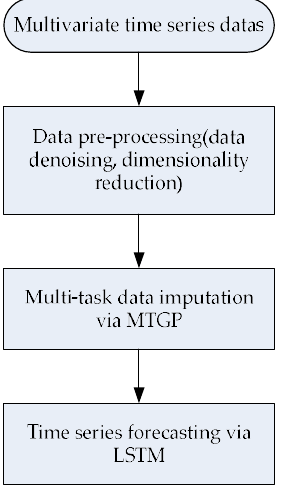
Figure 1. Flowchart of the proposed MT-LSTM method.